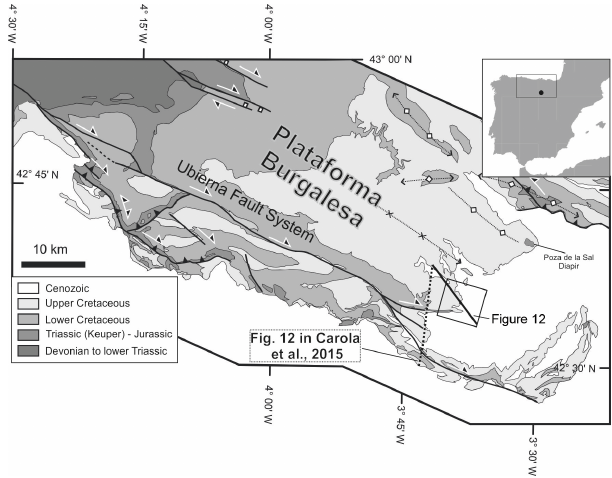
Figure 1. Location of the Hontomín site (black square) within the Plataforma Burgalesa (after Alcalde et al., 2014). Bold line repre- sents the location of the section shown in Fig.